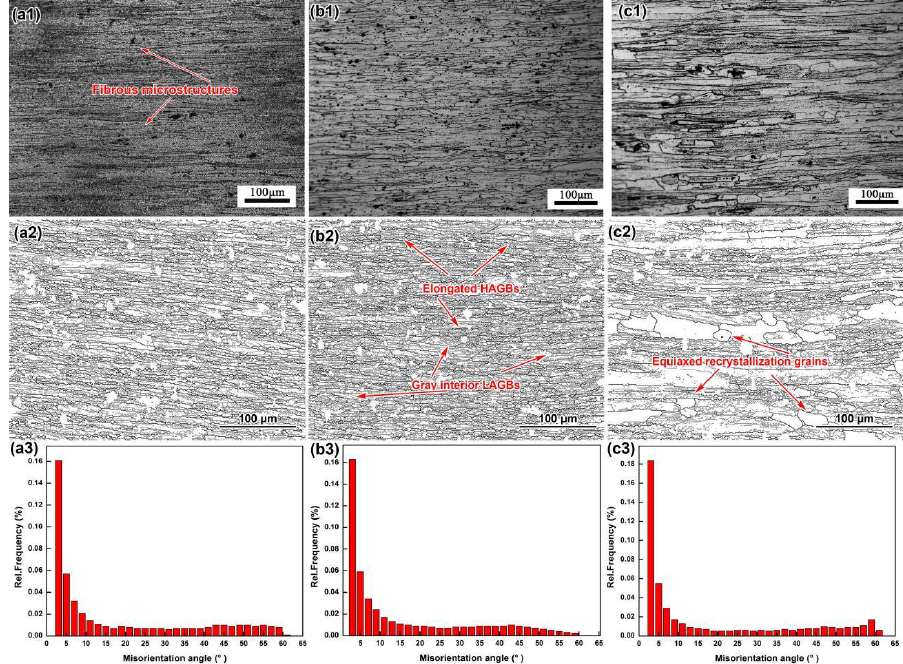
Figure 6. OM images ( a1–c1 ), EBSD (grain boundaries ( a2–c2 )) maps and grain misorientation angle ( a3–c3 ): ( a1–a3 ) for CRTMT-60%; ( b1–b3 ) for DRTMT-60%; ( c1–c3 ) for DRTMT-IA.